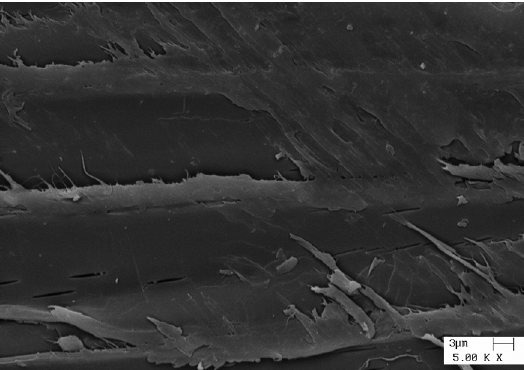
Figure 3. SEM micrography with 5000x magnification of Caixeta wood cells without treatment.